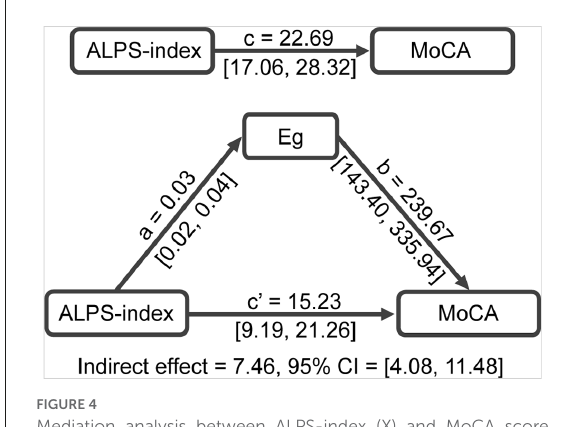
FIGURE4 Mediation analysis between ALPS-index (X) and MoCA score (Y), with Eg as mediator (M). ALPS, analysis along the perivascular space; Eg, global efficiency; MoCA, Montreal Cognitive